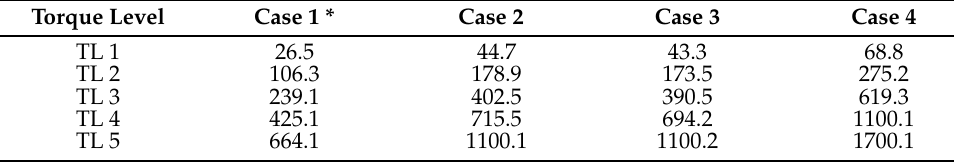
Table 5. The RMSE for sit to stand ( × 10 − 6 Nm/kg).